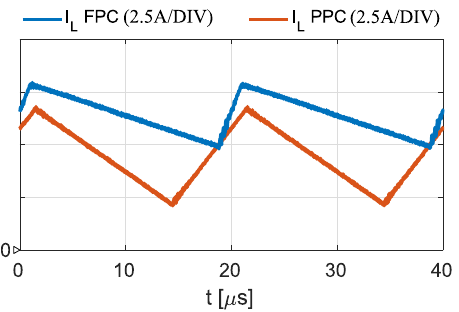
Figure 13. Experimental inductor current attained by the double-inductor topology.